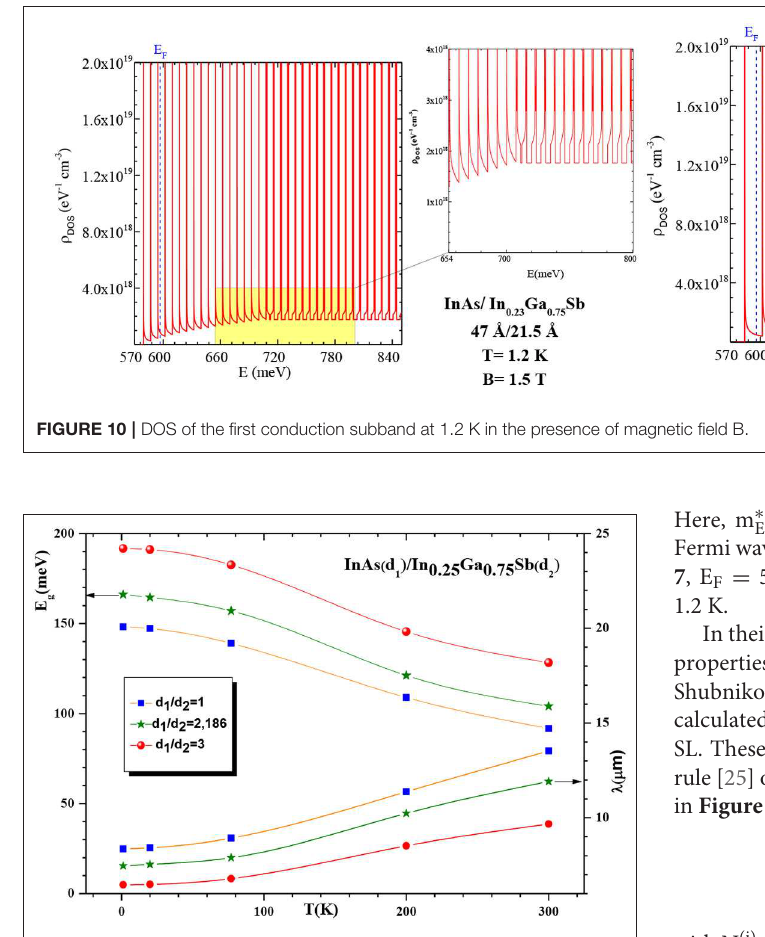
FIGURE 11 | SLs E g ( Ŵ ) and | λ c ( Ŵ )| as a function of temperature for various d 1 /d 2 in InAs(d 1 )/Ga 0.75 In 0.25 Sb(d 2 )